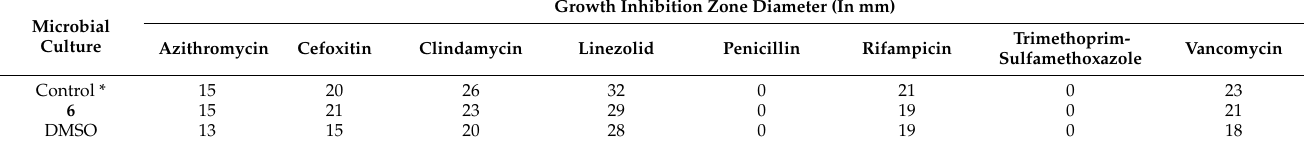
Table 4. Antibiotic susceptibility testing of S. aureus ATCC 6538 strain cultured in the presence of compound 6 tested at 250 µ g/mL and of DMSO control (growth inhibition zone diameters were measured in mm).